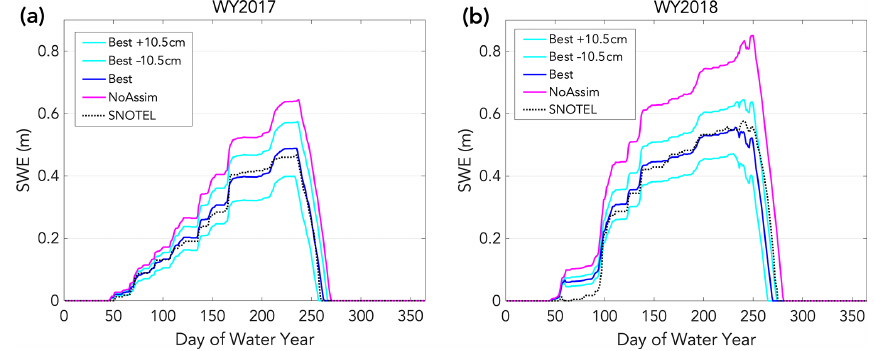
Figure 5. Snow water equivalent (SWE) time series results with measurement uncertainty included. The simulations with ± 10 . 5cm of SWE represent the upper and lower boundaries of error introduced when converting snow depth measurements to SWE using the Hill et al. (2019) method.